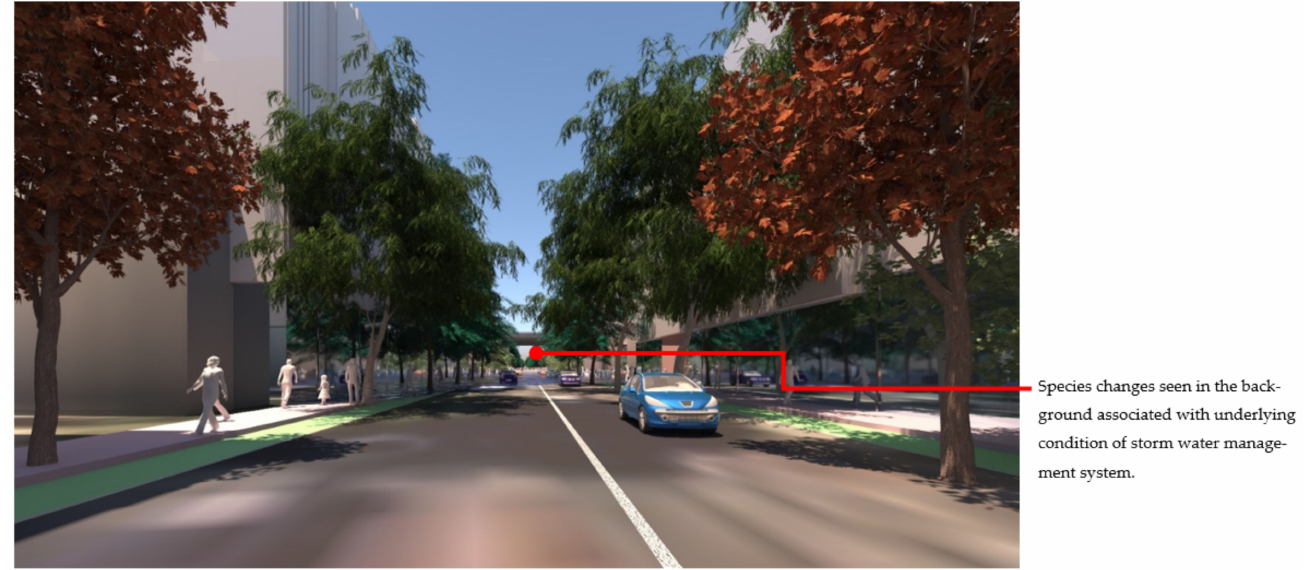
Figure 19. Macaulay Road view of Flood scenario (1) ‘land subject to inundation’ during flood (which can be seen in the background). The Angophora costata in the mid-ground occur over a symmetrical condition (dry and overshadowed in winter). Image by authors using multi-criteria street tree design decision support modelling approach in Autodesk™ 3ds Max™.